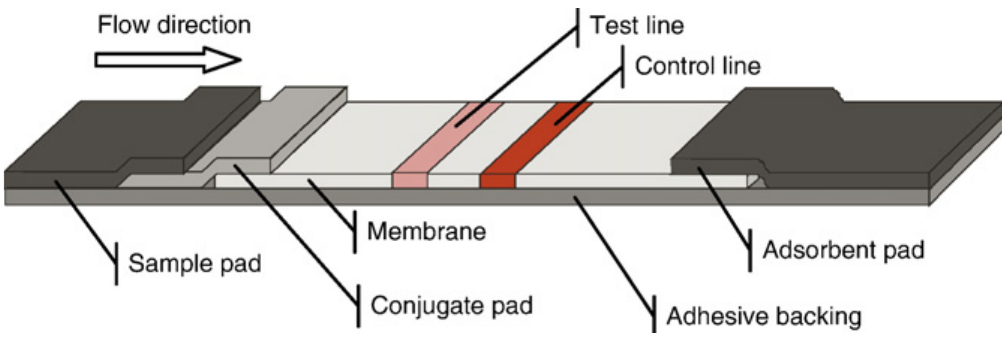
Figure 2. Standard layout of a lateral flow